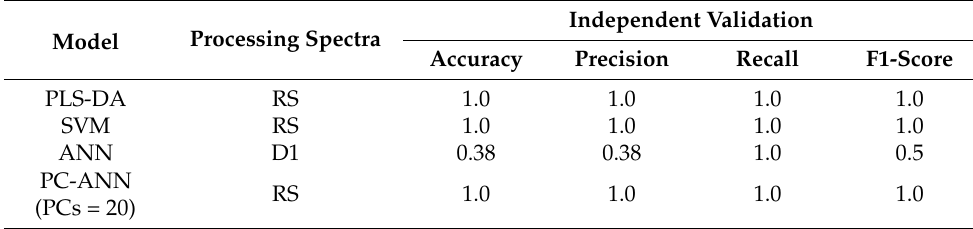
Table 7. Results of model validation on unknown